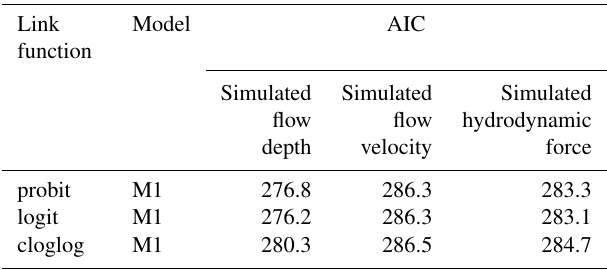
Table 8. AIC values for model M1 fitted to the simulated tsunami intensity measures of